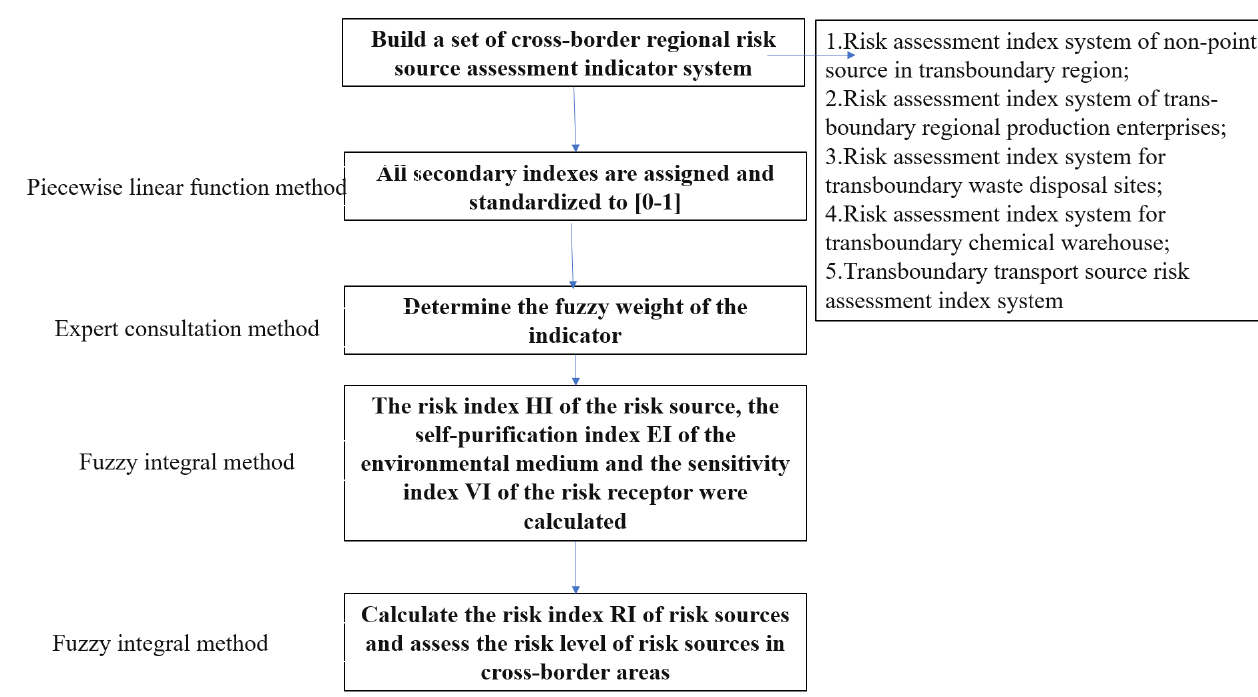
Figure 2. Classification of risk sources in the transboundary area.